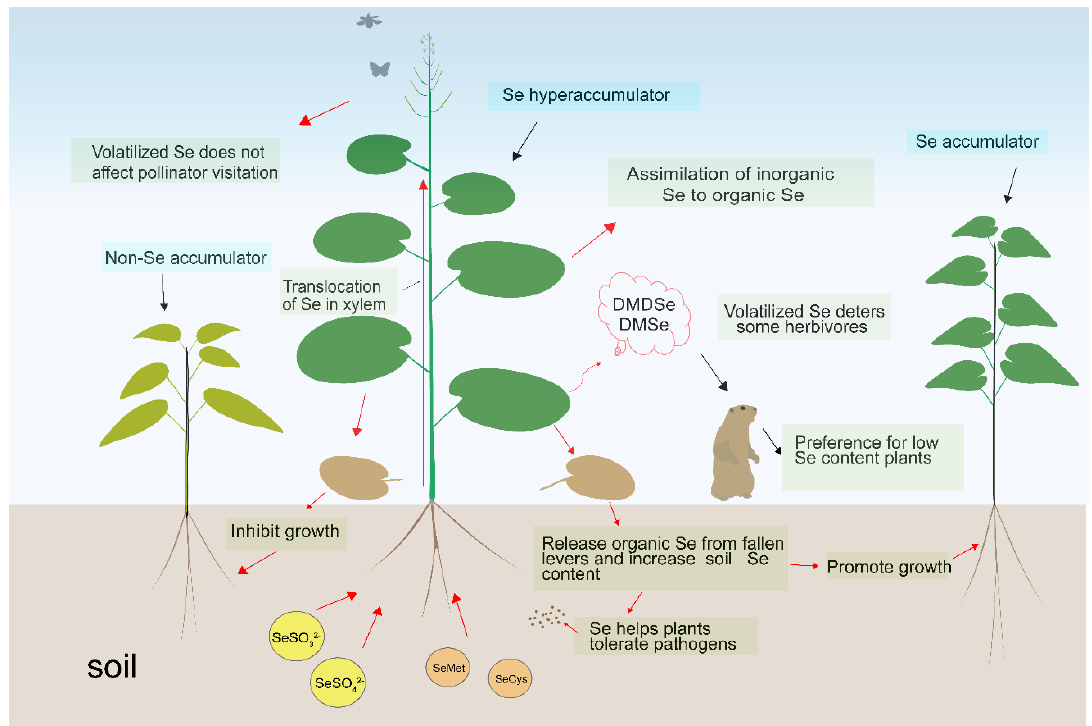
Figure 2. Pattern diagram of selenium participating in regulating plant ecosystem. Note: DMSe, dimethyl selenide; DMDSe, dimethyl diselenide; SeMet, selenomethionine; SeCys, selenocysteine.